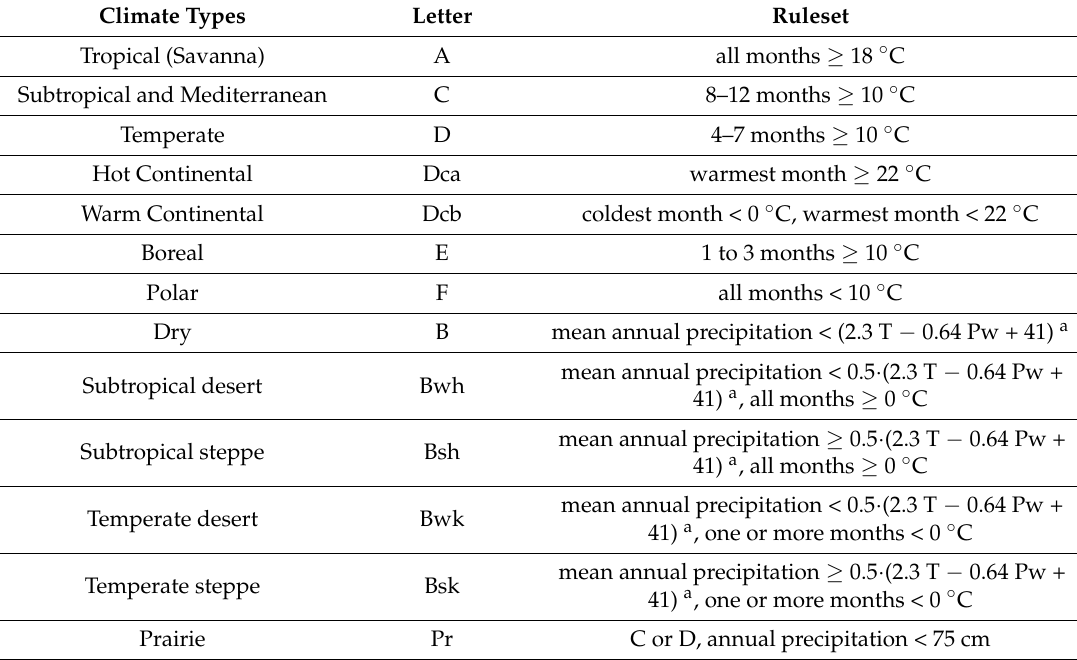
Table 2. Climate types defined by the Köppen-Trewartha climate